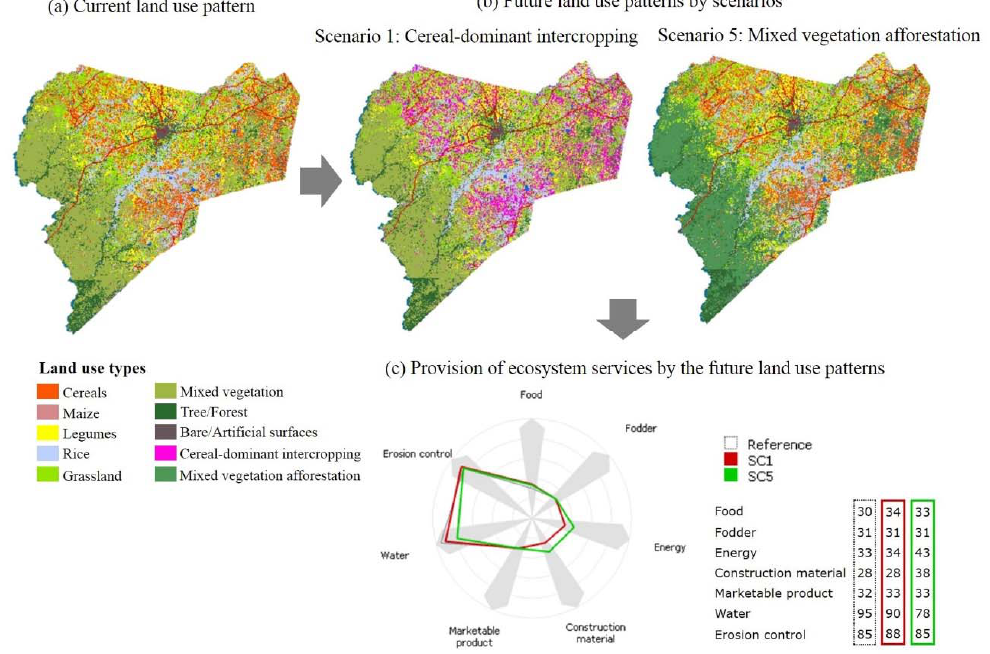
Figure 4. Future land use patterns of selected scenarios and spider charts for the ecosystem services balance supplied by the model output for Bolgatanga. As an example, influences of cereal-dominant intercropping (SC 1) and mixed vegetation afforestation (SC 5) on the current land use pattern were generated by cellular automaton ( b ). In the spider chart ( c ), changes in the provision of ecosystem services compared to the current provision of ecosystem services as reference are displayed for SC1 and SC5. The values of ecosystem services of the two scenarios corresponding to the spider chart are presented in the table.